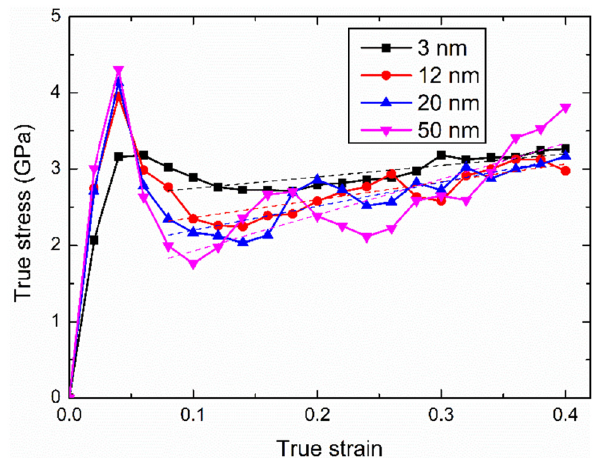
Figure 3: Stress versus strain curves for the MD samples with di ff erent grain sizes, with the dashed lines being the linear fi tting for the strain range 0.08 –